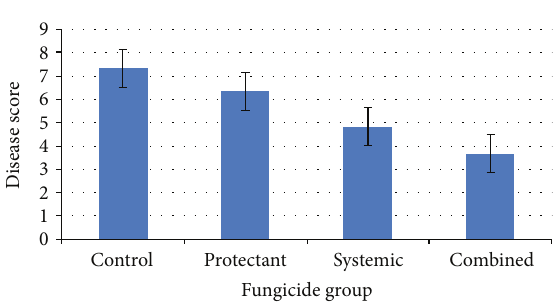
Figure 1: Effect of fungicides with different modes of action on Botrytis gray mold disease severity in susceptible chickpea variety